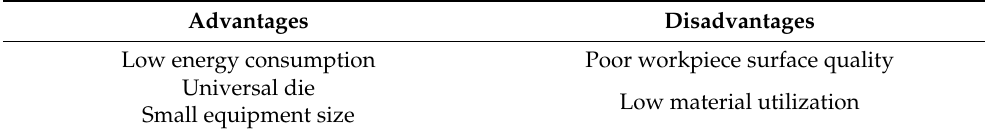
Table 2. Comparison between TRSR process and forging